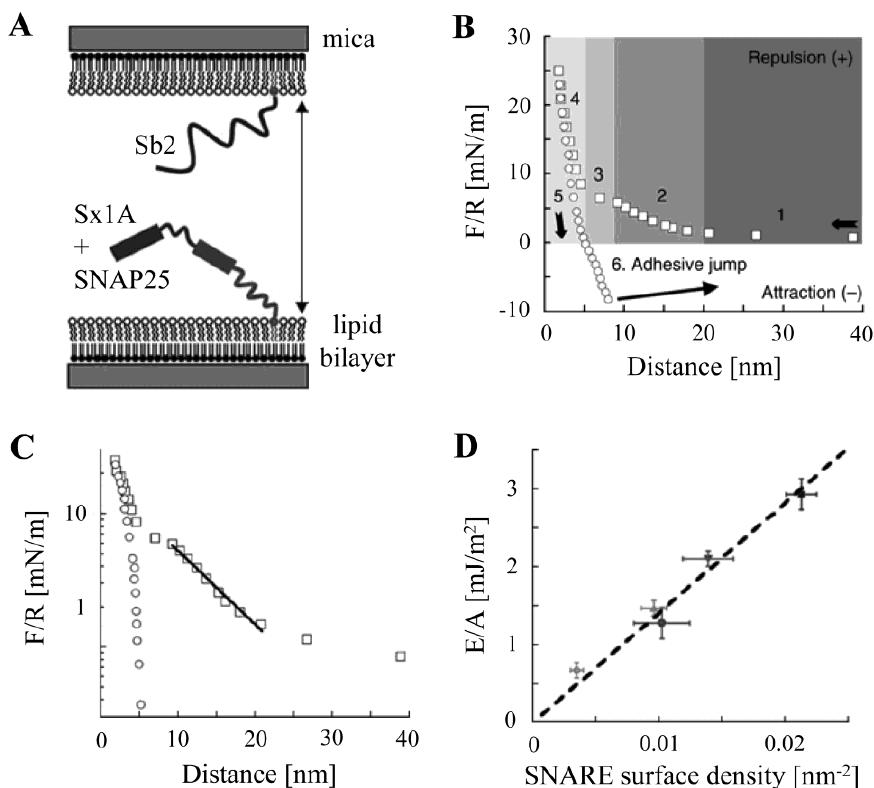
FIGURE 4. The SFA approach for obtaining the disassembly energy of the ternary SNARE complex. (A) Schematic of the experimental approach. The recombinant cytoplasmic domain of Sb2 is attached at its C- terminus to the outer layer of the lipid bilayer predeposited onto a mica surface. The cytoplasmic domain of Sx1A is attached using the same approach onto an apposing mica surface. SNAP25 is precomplexed to Sx1A so that these proteins form a binary SNARE complex. Two mica surfaces containing SNARE proteins anchored to the lipid bilayers are brought into contact and then taken apart (double arrow) by means of a leaf spring supporting one of the mica cylinders. Drawing is not to scale. (B) The graph shows the typical force-distance curve during the assembly (approach, horizontal arrow) and disassembly (downward arrow) of ternary Sb2-Sx1A-SNAP25 complexes. Numerated (1–5) and shaded areas indicate various segments of the experiment (see text for details). During the approach, there are repulsion (+) forces developed between proteins, while the adhesion between them causes attractive forces (–) during the retraction of mica surfaces. The ternary SNARE complexes are dismantled at a finite distance and force detected as an adhesive jump (point 6, long arrow) in the graph. The force (F) is normalized to the radius of the curvature (R) of the mica surfaces/cylinders. (C) Measurement of SNARE surface density. The measurements in area 2 of the approach, which report on long-range steric repulsions between SNAREs, can be used to deduce the SNARE surface density using a fit to the mushroom model (solid line). (D) The ternary SNARE complex free energy. The adhesion energy of SNAREs per unit area is plotted as a function of their surface density. Each symbol represents mean  sem of measurements originating from independent pairs of mica surfaces. The dashed line represents the fit to the data. The slope of this line corresponds to the change of free energy due to disassembly of a single ternary SNARE complex. Modified from Li et